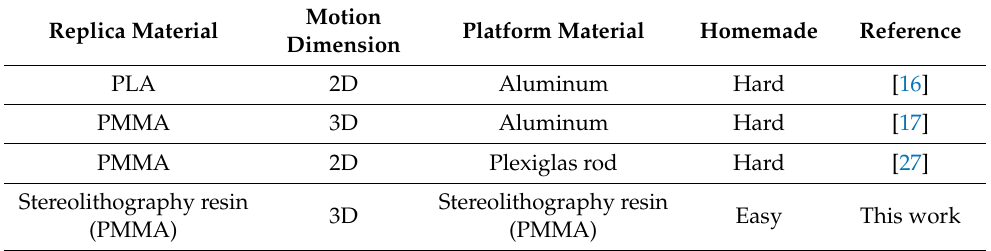
Table 1. Comparison of our replica materials with those from literature